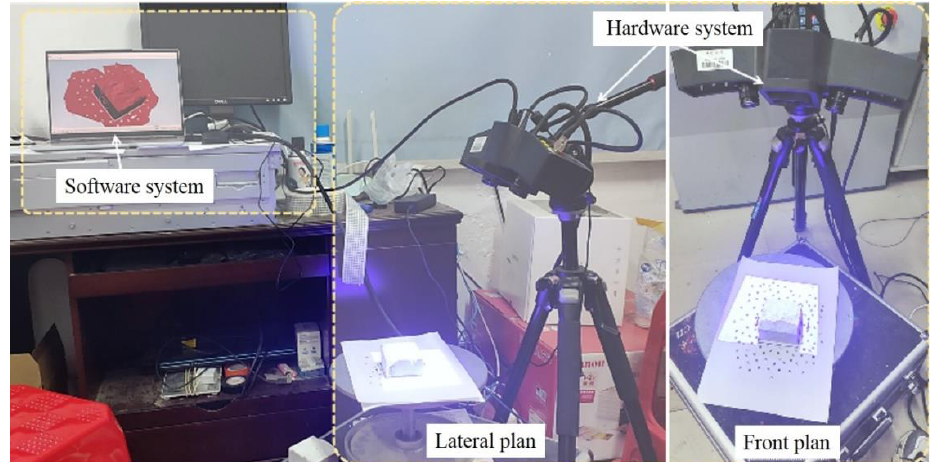
Figure 3. The components of interface topography-sensing system.